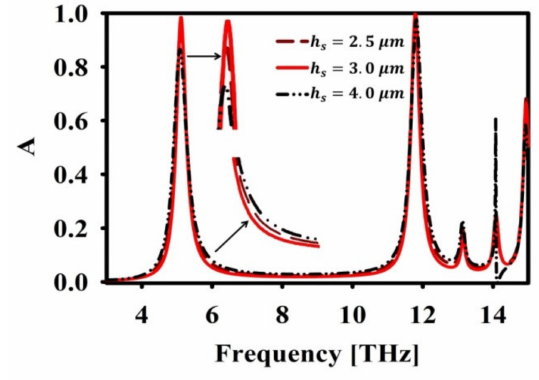
Figure 6. Effect of h s in absorption (A)